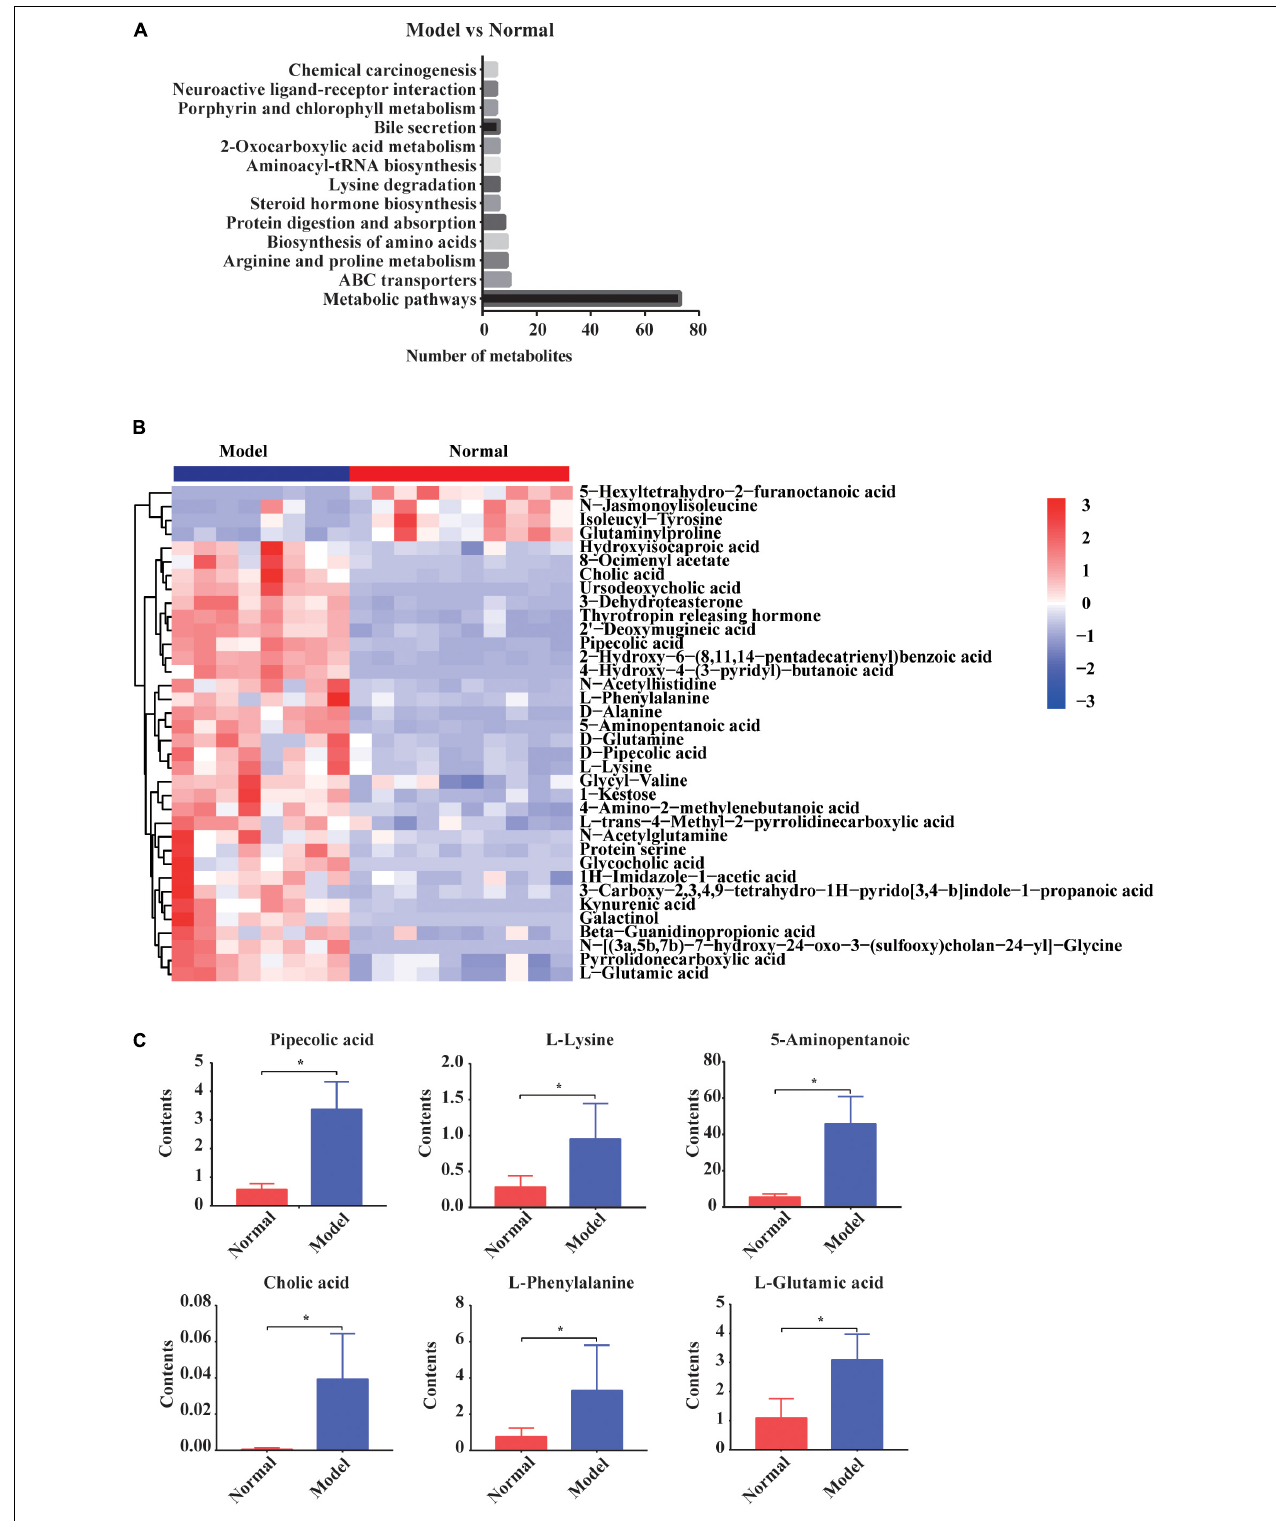
FIGURE 4 | The changed gut metabolites and signaling pathways in normal pregnant rats vs. GDM rats. (A) Gut metabolites’ signaling pathways in KEGG Database. (B) Hierarchical clustering analysis of 36 metabolites in GDM rats. (C) The comparison of amino acids and bile acids that participated in gut metabolites’ signaling pathways by independent samples t -test or non-parametric test. * P <